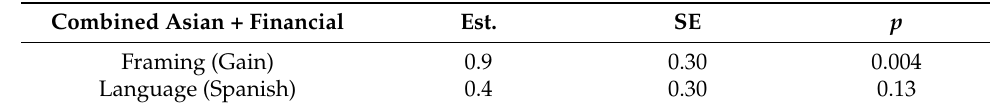
Table 7. Regression model, Asian disease and Financial crisis. Table 6. Regression model, Asian disease and Financial crisis combined.